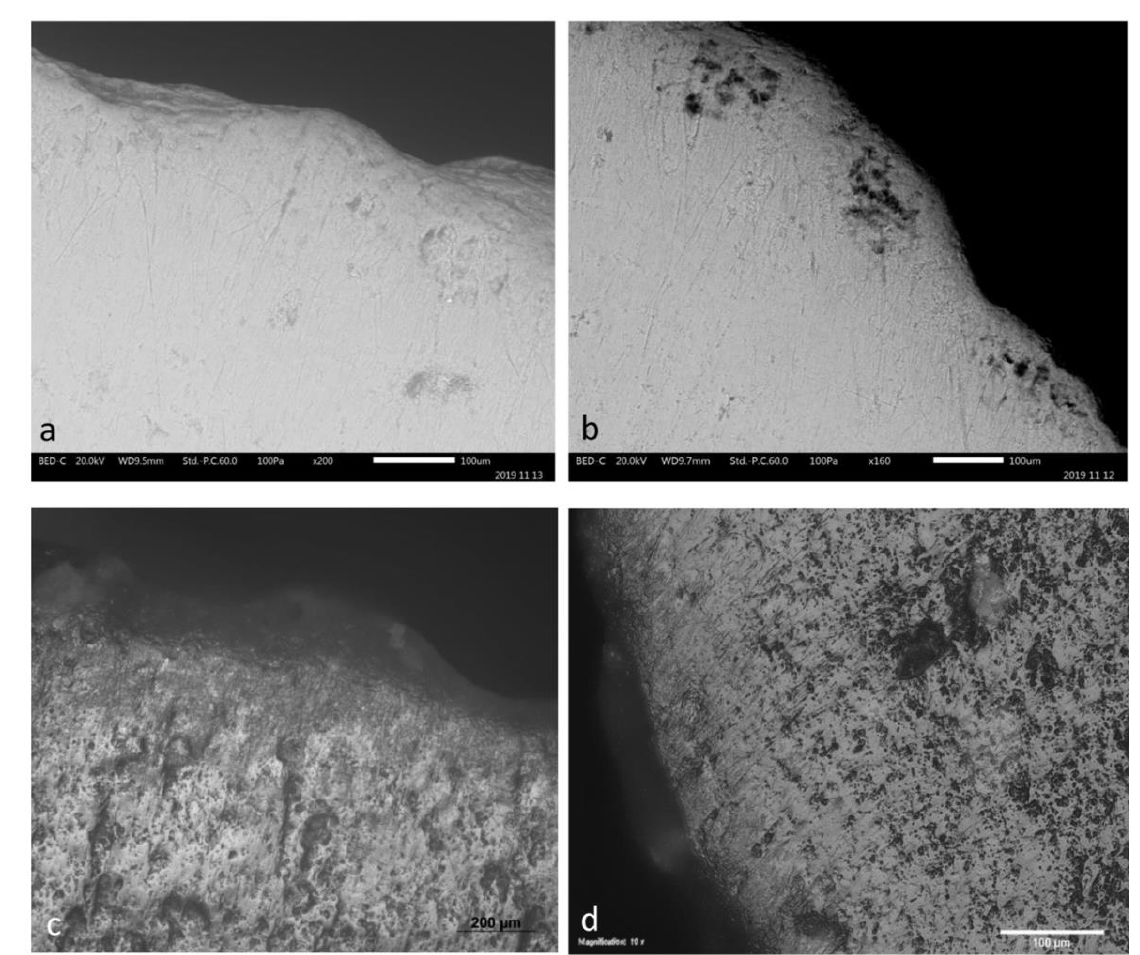
Figure 10. Details of wear traces and residues observed on the distal edge of scraper LB57A_1 interpreted as having been used on a soft material, most likely a vegetal material rich in silica: a)+b) backscattered electron images showing the rounded distal ventral edge of the tool, with striations indicating the transversal motion and the adhering organic residual depositions; c)+d) microscopic detail of the distal rounded edge, with a rough and bright polish and numerous striations